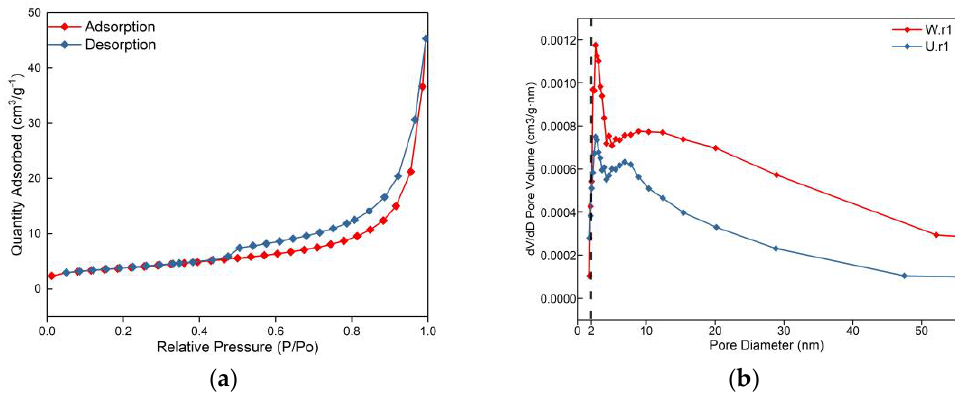
Figure 3. Figures of nitrogen adsorption for the weathering rind and unweathered rind: ( a ) Adsorption-desorption isotherms in the weathering rind; ( b ) Adsorption-desorption isotherms in the weathering rind and the unweathered rind.